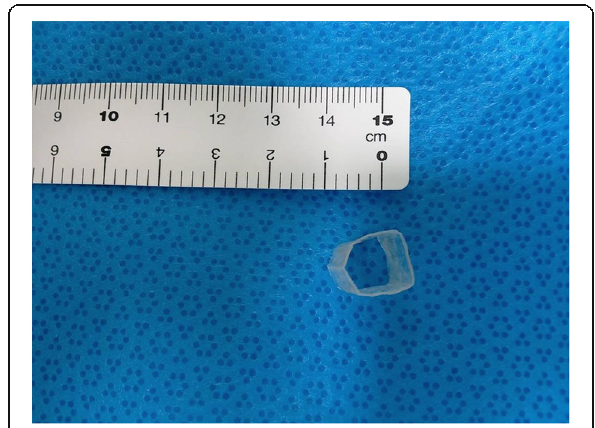
Fig. 3 A circular plastic foreign body (cross-sectional diameter of 1.2 × 1.0